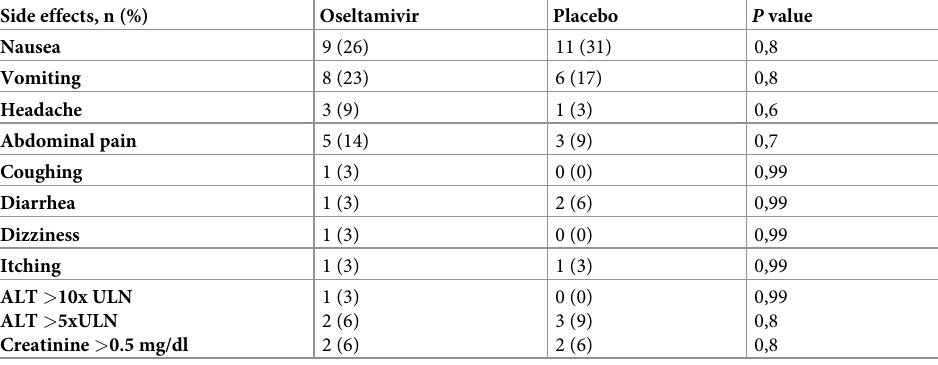
Table 2. Reported side effects. Side effects, n